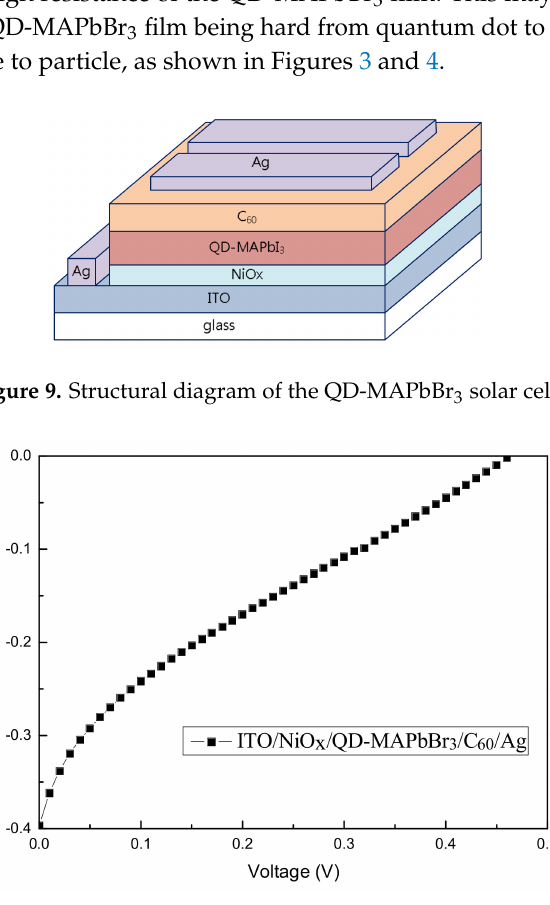
Figure 10. Typical J–V curve of the ITO/NiO/QD-MAPbBr 3 /C 60 /Ag structure solar